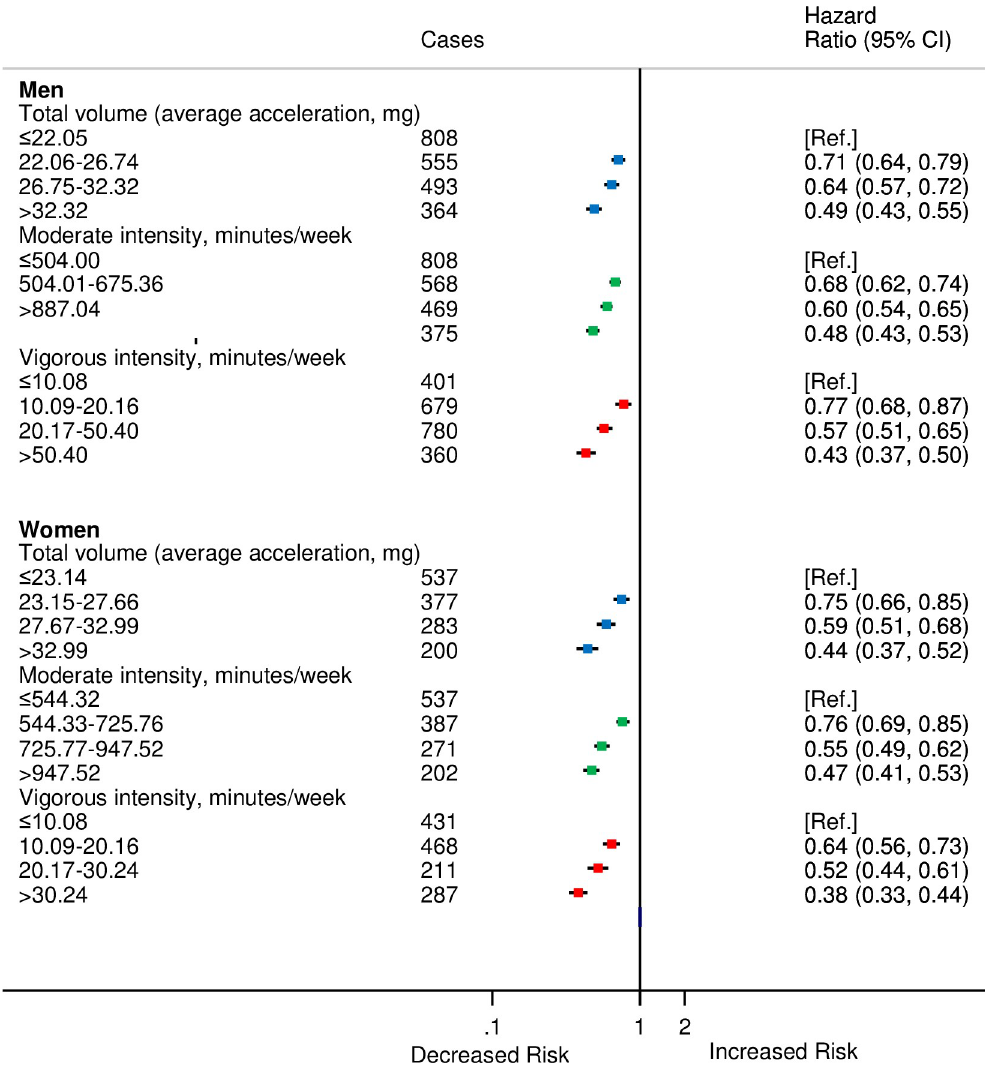
Fig 2. Dose–response association (HRs and associated 95% confidence interval band) between accelerometer- measured (A) total volume of PA, (B) moderate-intensity PA, and (C) vigorous-intensity PA and incident CVD using restricted cubic splines with knots at 25th, 50th, and 75th centiles of the distribution of PA (reference category = 17 milligravities (mg) for total volume of PA; 302. 4 minutes/week for moderate intensity PA; 10.08 week for vigorous intensity PA). Also shown are histograms of PA for total volume of PA in milligravities and for moderate-intensity and vigorous-intensity PA in minutes/week. CVD, cardiovascular disease; HR, hazard ratio; PA, physical activity.